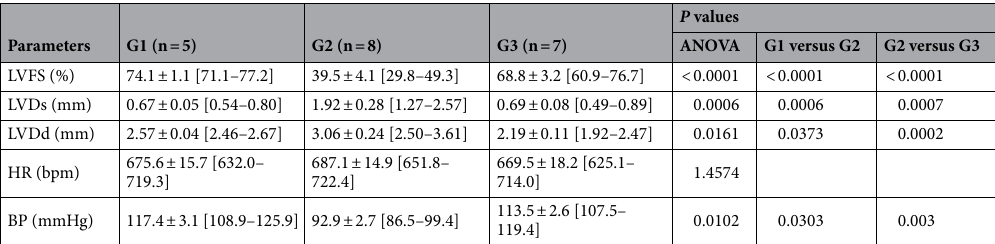
Table 1. Echocardiographic data on day 21 in experimental autoimmune myocarditis (EAM) mice. Data are mean ± SEM [95% confidence interval]. Echocardiographic findings on day 21 in non-EAM mice daily treated with vehicle only (G1: n = 5) or in EAM mice treated with vehicle (G2: n = 8) or selective prostaglandin E2 receptor 4 agonist (ONO-0260164) (G3: n = 7) from day 14 to day 21. P values were calculated with 2-way ANOVA followed by the Bonferroni-Dunn post hoc testing method. LVFS left ventricular fractional shortening, LVDs LV end-systolic dimension, LVDd LV end-diastolic dimension, HR heart rate, BP systolic blood pressure.